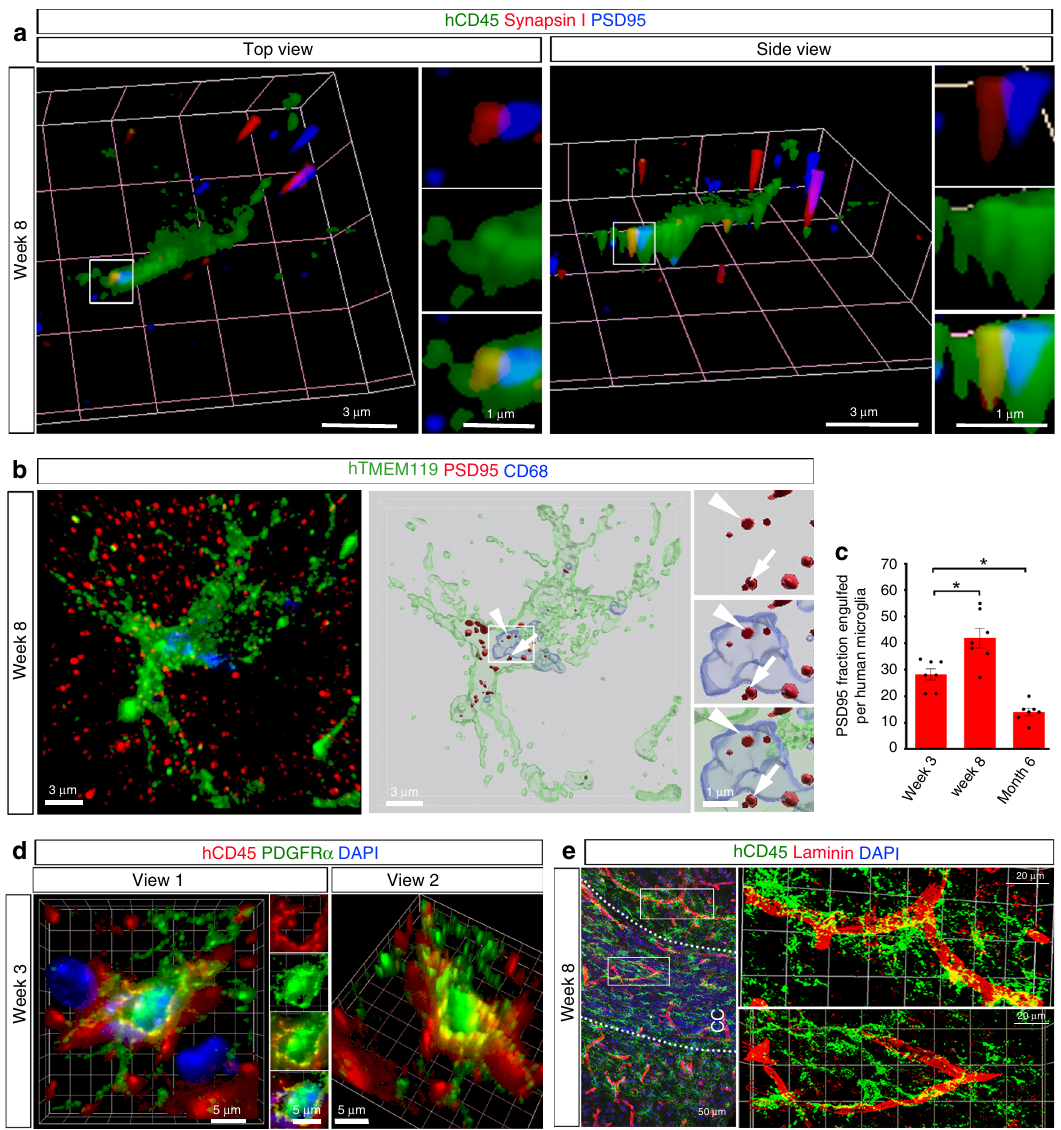
Fig. 3 Human PSC-derived microglia are functional in the mouse brain. a Representative 3D reconstruction of super-resolution images showing hCD45 + donor-derived microglia engulf synaptic proteins, synapsin I, and PSD95 in gray matter at 8 weeks post transplantation. Scale bars, 3 and 1 μ m in the original or enlarged images, respectively. b Representative images showing colocalization of hTMEM119 (green), PSD95 (red), and CD68 (blue) staining in gray matter at 8 weeks post transplantation. Left, a raw fl uorescent super-resolution image. Right, a 3D-surface rendered image from the same raw image. Arrows and arrowheads depict PSD95 (red) engulfed within microglia (green) or within lysosome (blue), respectively. Scale bars, 3 and 1 μ m in the original or enlarged images, respectively. c Quanti fi cation of PSD95 + fraction engulfed per microglia from cerebral cortex at the three time points ( n = 7 mice for each time point). The data are pooled from the mice received transplantation of microglia derived from both hESCs and hiPSCs One-way ANOVA test, * P < 0.05. Data are presented as mean ± s.e.m. Source data are provided as a Source Data fi le. d Representative 3D reconstruction of super-resolution images showing that hCD45 + hPSC-derived microglia phagocytize PDGFR α + oligodendroglial cells in the corpus callosum at 3 weeks post transplantation. Scale bars, 5 μ m. e Representative images showing the interaction between laminin + blood vessels and hCD45 + human microglia in gray matter and white matter at 8 weeks post transplantation. Scale bars, 50 and 20 μ m in the original or enlarged images,